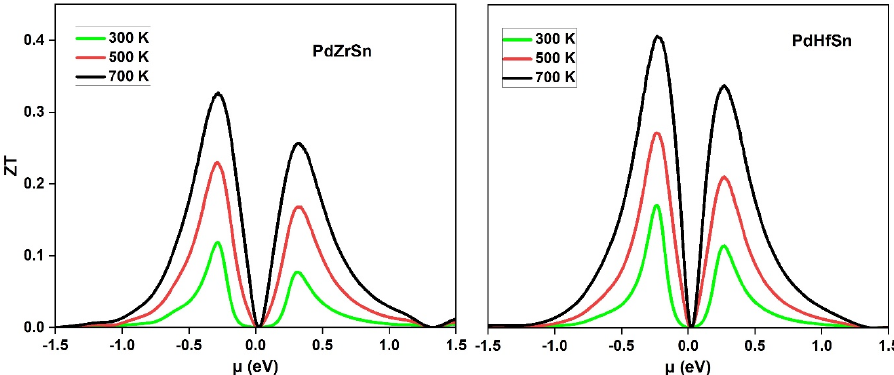
Figure 7. Variation of Figure of merit (ZT) of PdZrSn and PdHfSn materials with chemical potential at various temperatures. Table 4. Comparison of Seebeck coefficient (S), electrical conductivity ( (cid:2026) ), and thermal conductivity ( (cid:2193) (cid:2168) ) (at 300 K) and maximum ZT of PdXSn (X = Zr, Hf) with other half Heusler materials.